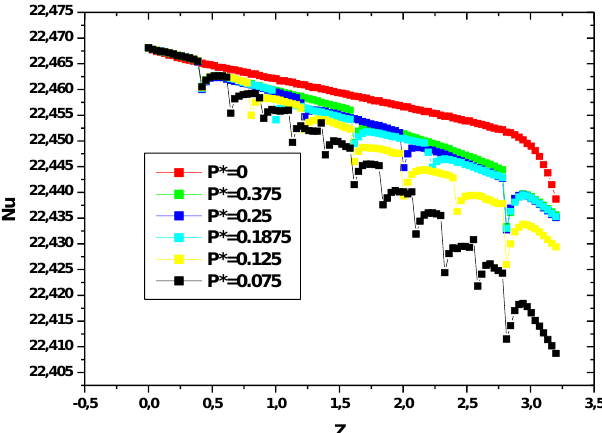
Fig. 9. Variation of Nusselt number for Re